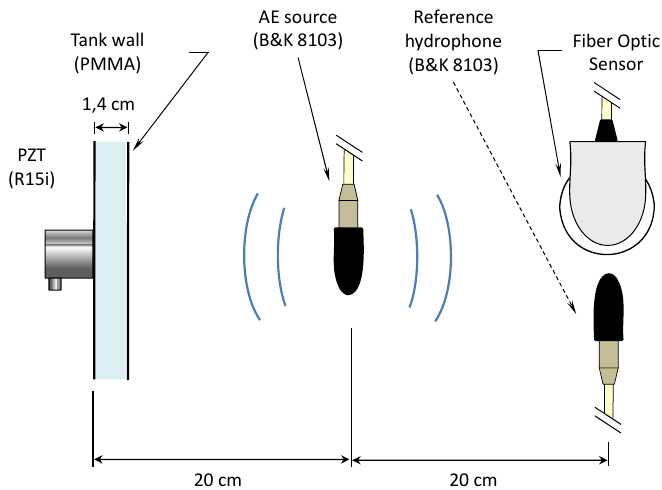
Figure 4. Experimental set-up for the calibration of the sensor in